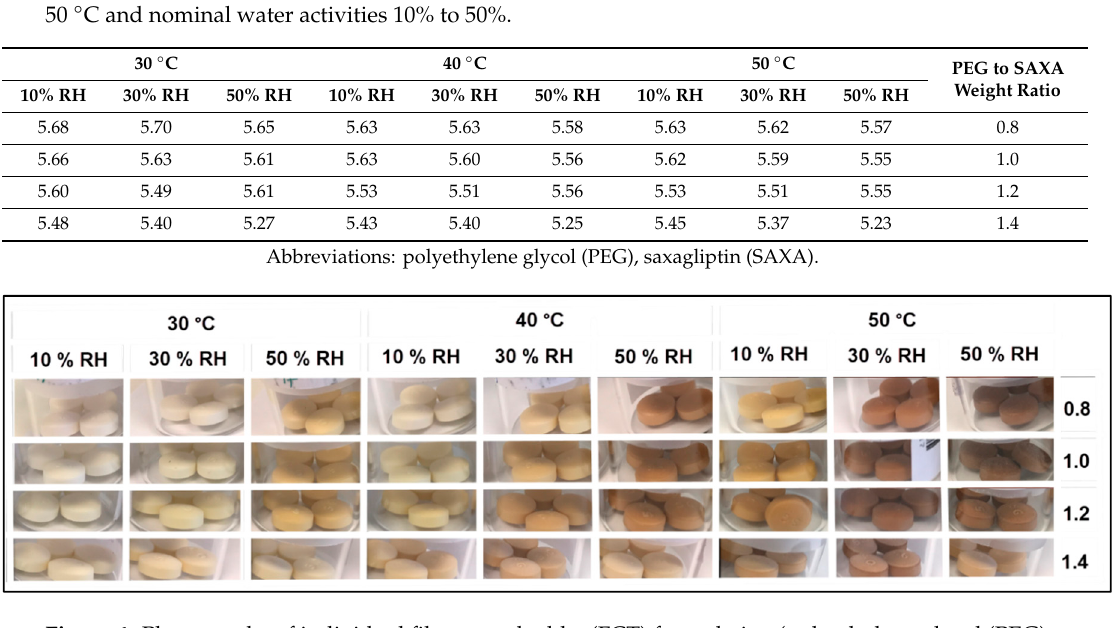
Figure 4. Photographs of individual film-coated tablet (FCT) formulation (polyethylene glycol (PEG) to saxagliptin (SAXA) = 0.8, 1.0, 1.2, and 1.4) exposed to different temperatures (30–50 °C) and relative humidity conditions (10%–50% RH). For sake of brevity, only two months of stability results are presented.